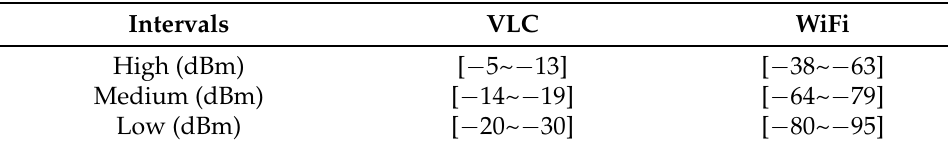
Figure 3. Hybrid VLC–WiFi RSS time series for training. Table 2. RSS Dataset